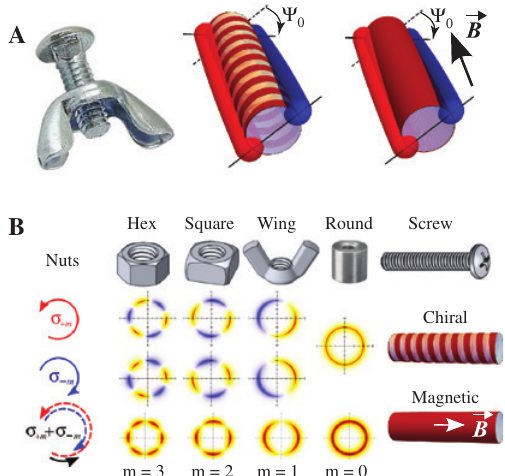
Figure 2: Structural and electromagnetic chirality of functional